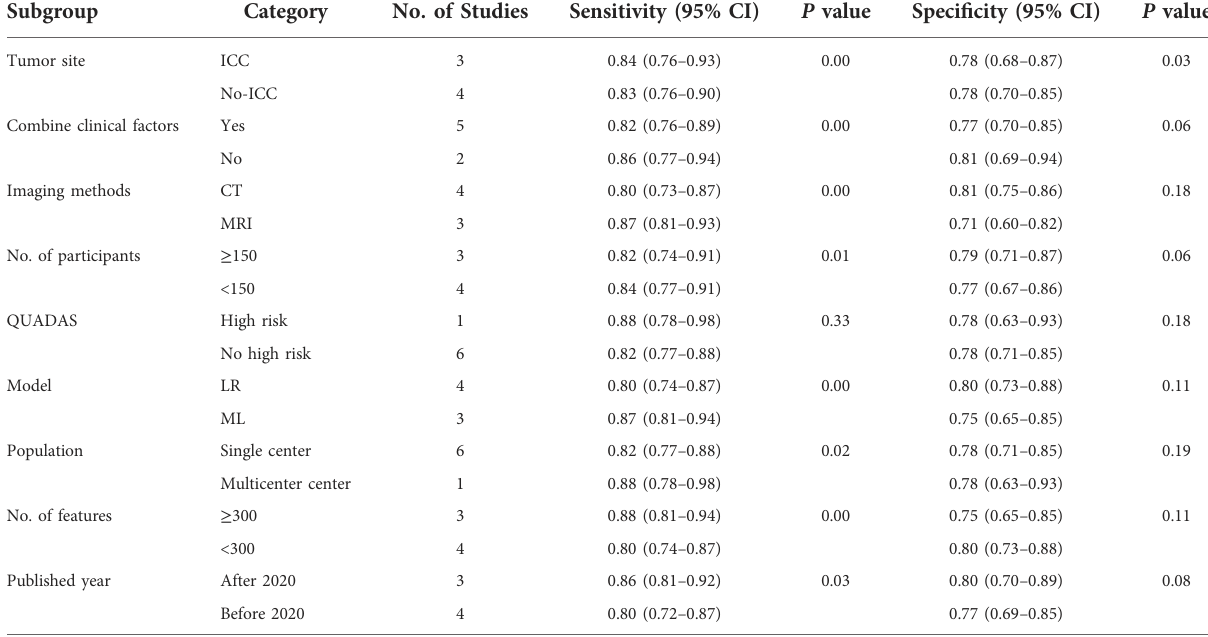
TABLE 3 Univariable meta-regression and subgroup